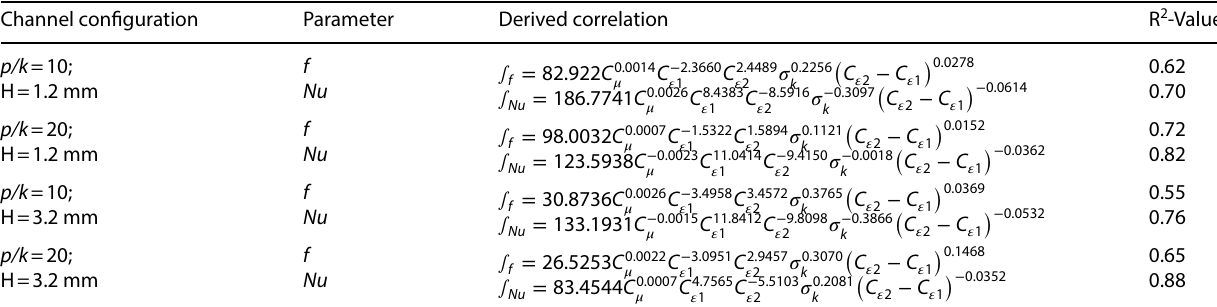
Table 4 Derived correlations using multivariate nonlinear regression method Channel configuration Parameter Derived